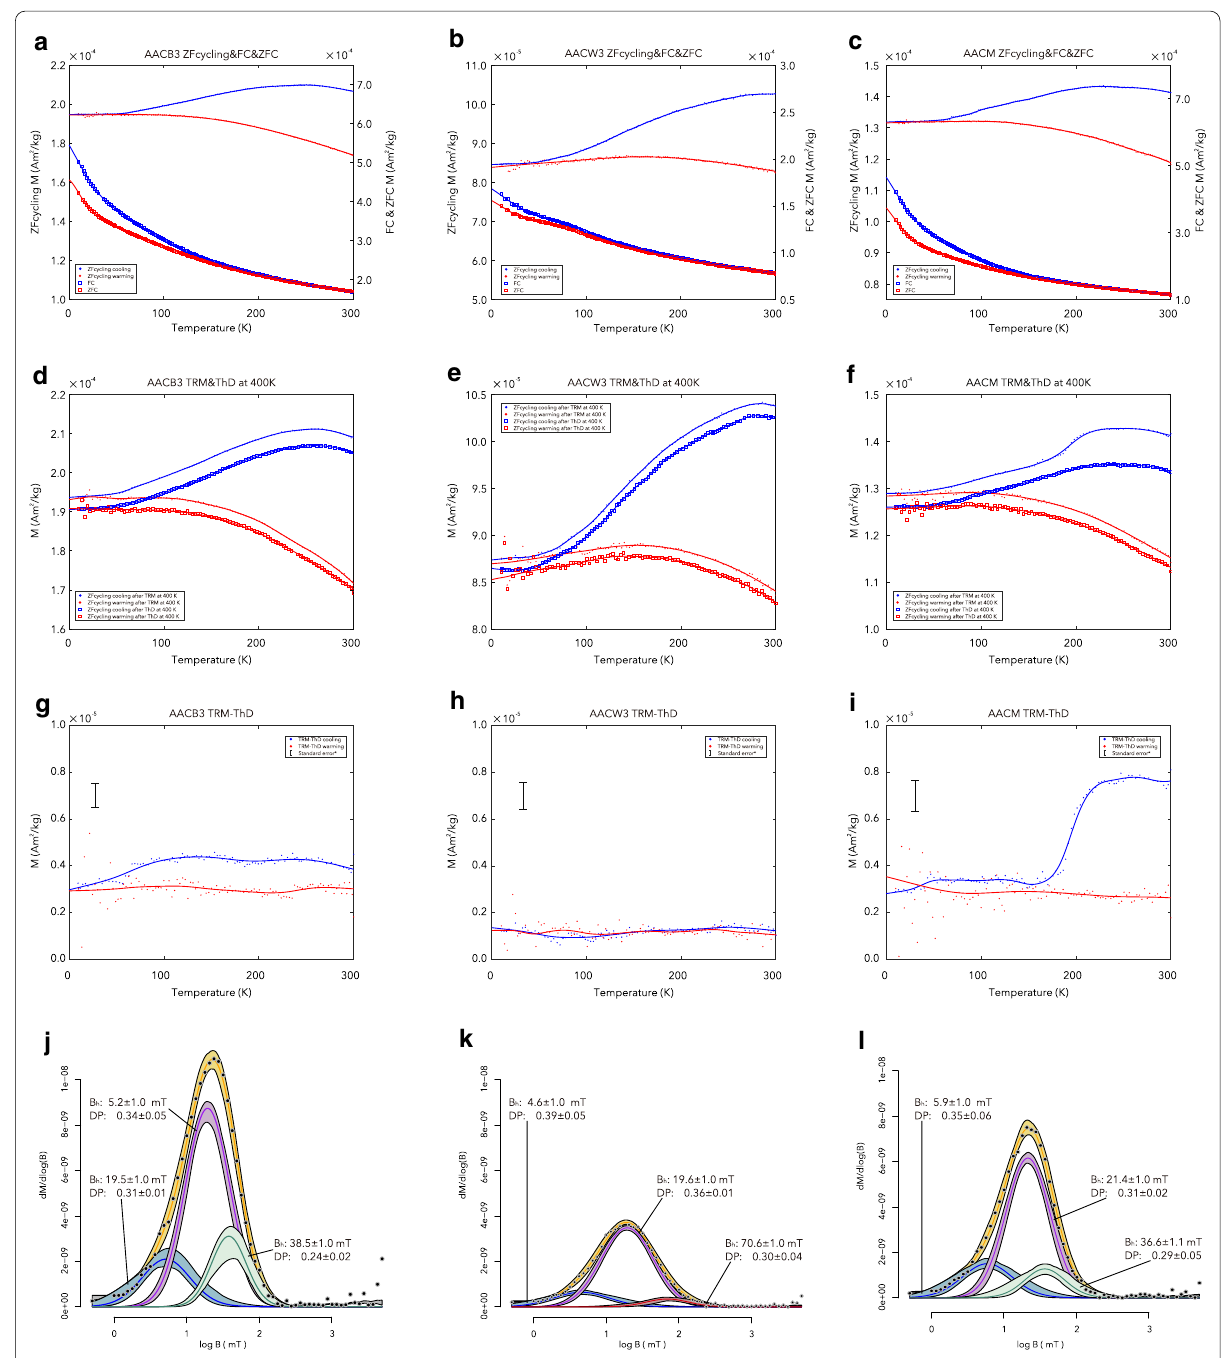
Fig. 4 ZF-cycling curves and FC/ZFC curves of a AAC-B3 (the gray layer), b AAC-W3 (the white inner part), and c AAC-M (the mixture of gray layers and white part including reddish-brown layer); ZF-cycling curves after TRM at 400 K and ZF-cycling curves after ThD at 400 K of d AAC-B3, e AAC-W3, and f AAC-M; the difference between ZF-cycling curves after TRM and ZF-cycling curves after ThD of g AAC-B3, h AAC-W3, and i AAC-M; unmixing models of IRM acquisition curves of j AAC-B3, k AAC-W3, l AAC-M. B h and DP are the mean coercivity and the dispersion parameter (given by one standard deviation) of an individual grain population assuming a Gaussian distribution in log space,